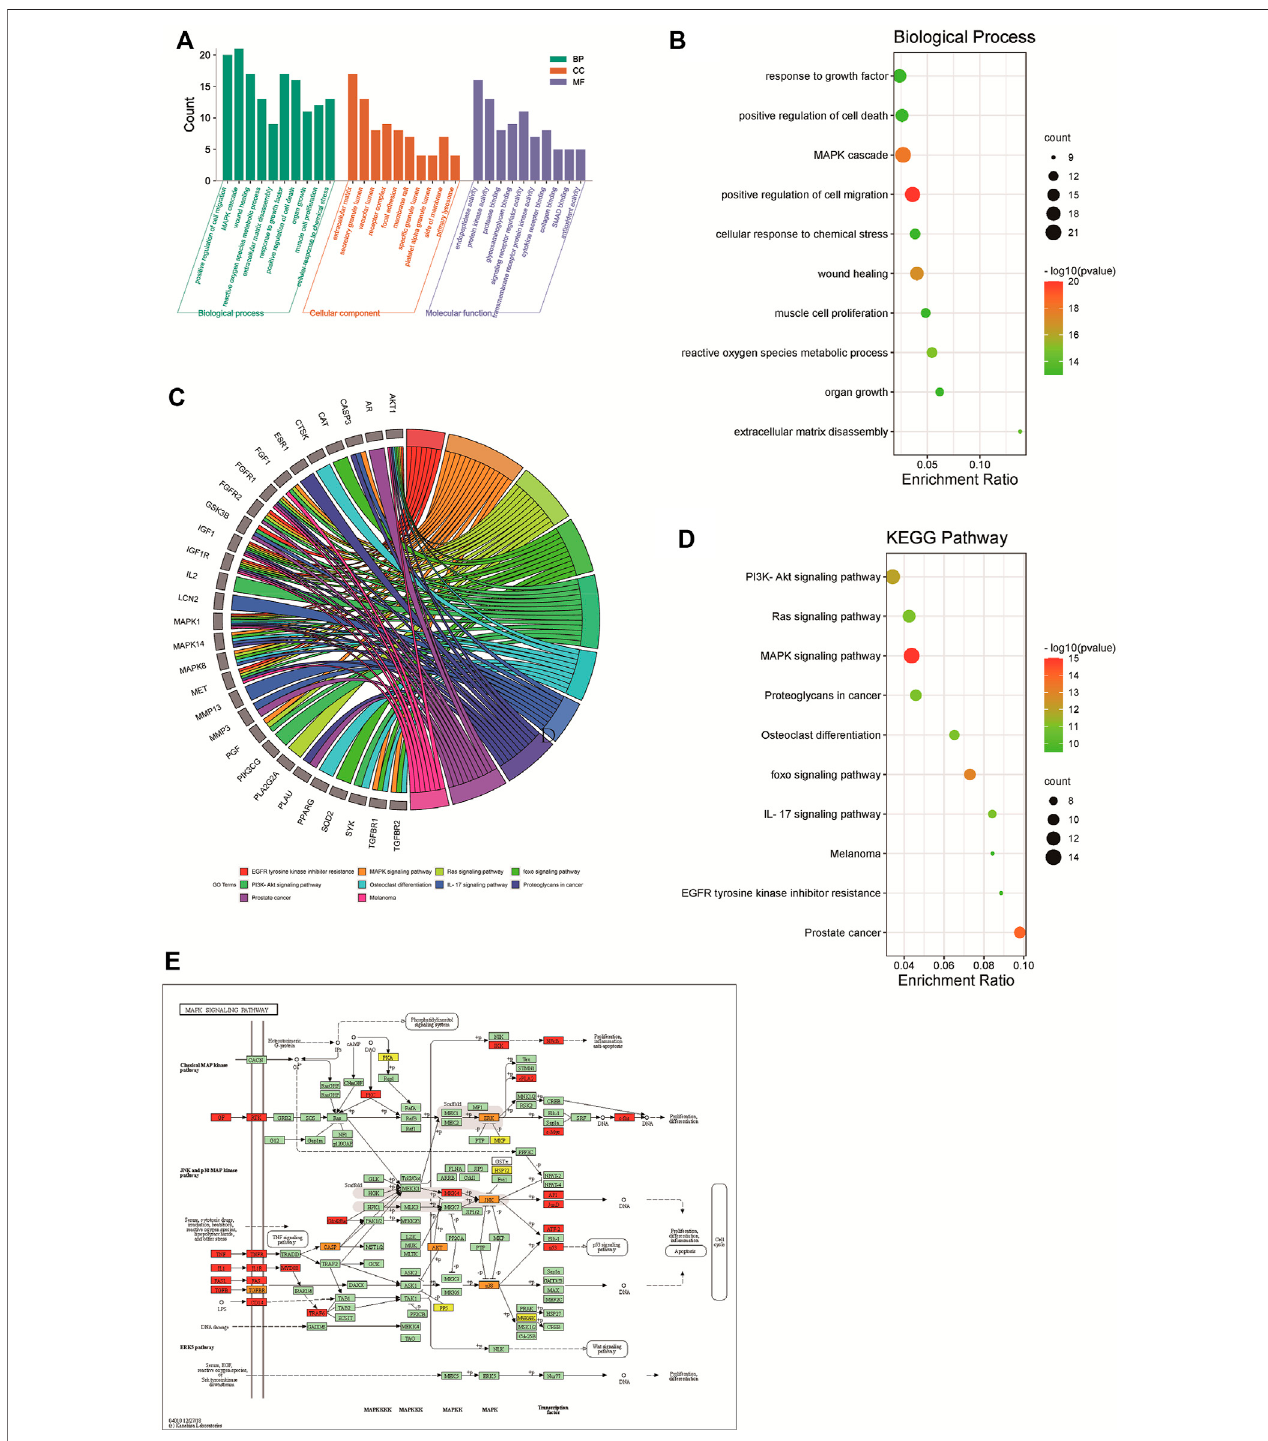
FIGURE 5 | GO function and KEGG pathway enrichment analyses of CX in the treatment of OA. (A) The GO function analysis, including biological process (BP), cellular component (CC), and molecular function (MF). (B) Bubble diagram of BP enrichment. (C) Gene ontology chord of the top 10 pathways in the CX anti-OA (D) Bubble diagram of KEGG pathway enrichment. (E) The MAPK pathway was colored by the KEGG mapper, the orange targets represent CX anti-OA, yellow represents other targets of CX not involved in OA treatment, and red represents other targets of OA in the MAPK pathway.